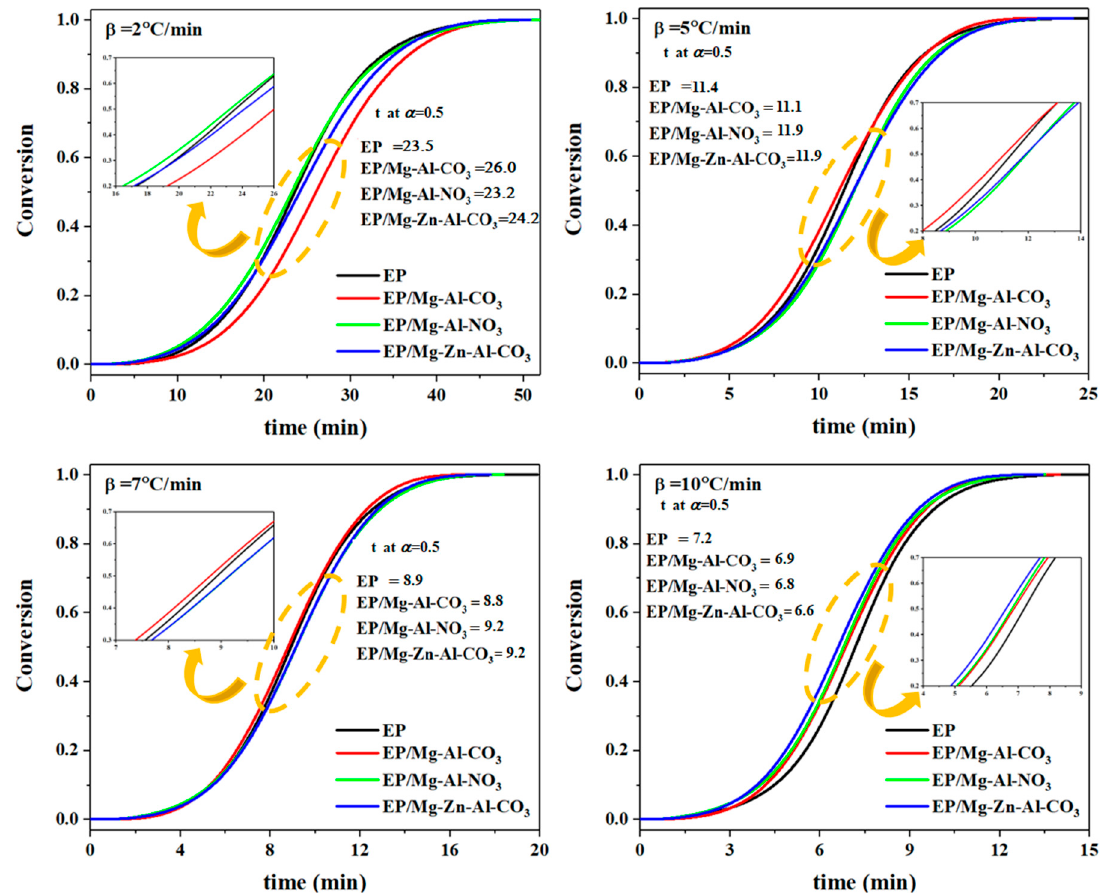
Figure 2. The fractional extent of conversion as a function of reaction time for EP, EP/Mg-Al-CO 3 , EP/Mg-Al-NO 3 and EP/Mg-Zn-Al-CO 3 nanocomposites at heating rates of 2, 5, 7 and 10 °C ∙ min − 1 .